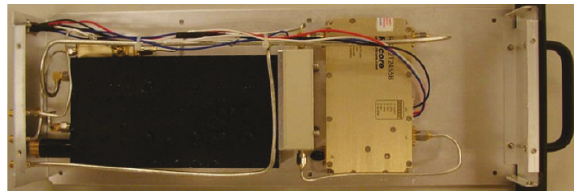
Figure 9: Photograph of the FEU for the m-WiMAX SA BS.